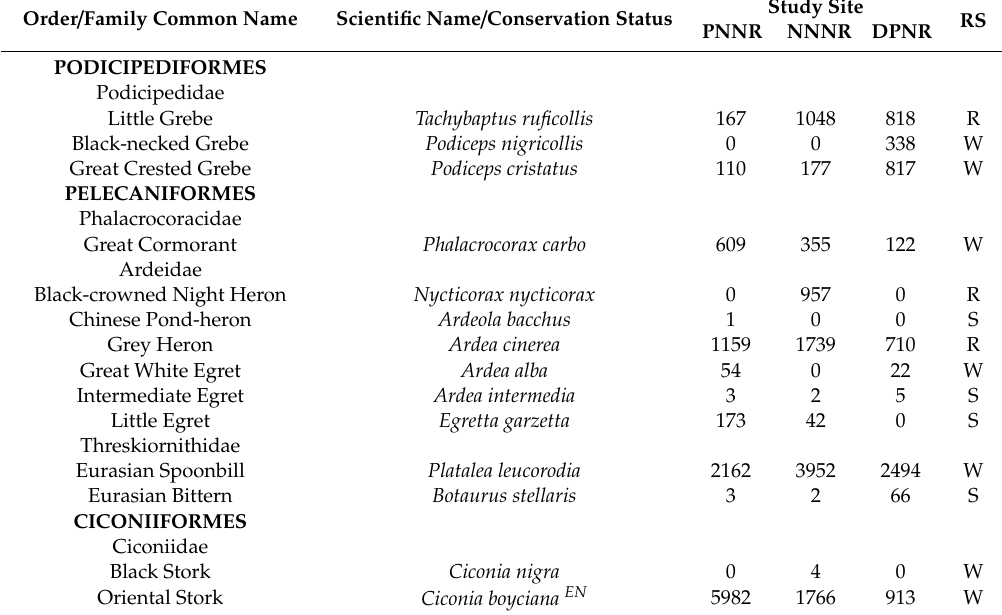
Table A1. List of wintering waterbird species and the total individual numbers recorded in five consecutive winter season surveys at each study site of Poyang Lake,